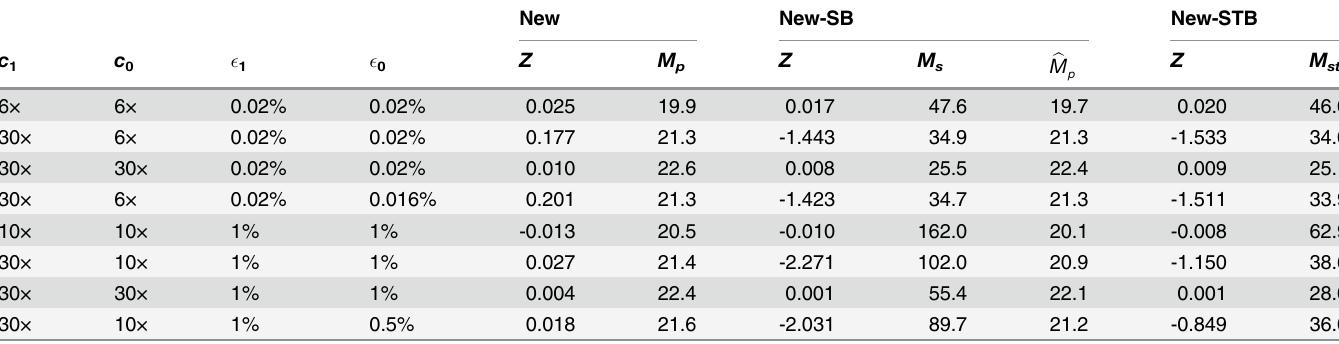
Table 2. Other simulation results for the weighted burden test under the null hypothesis.